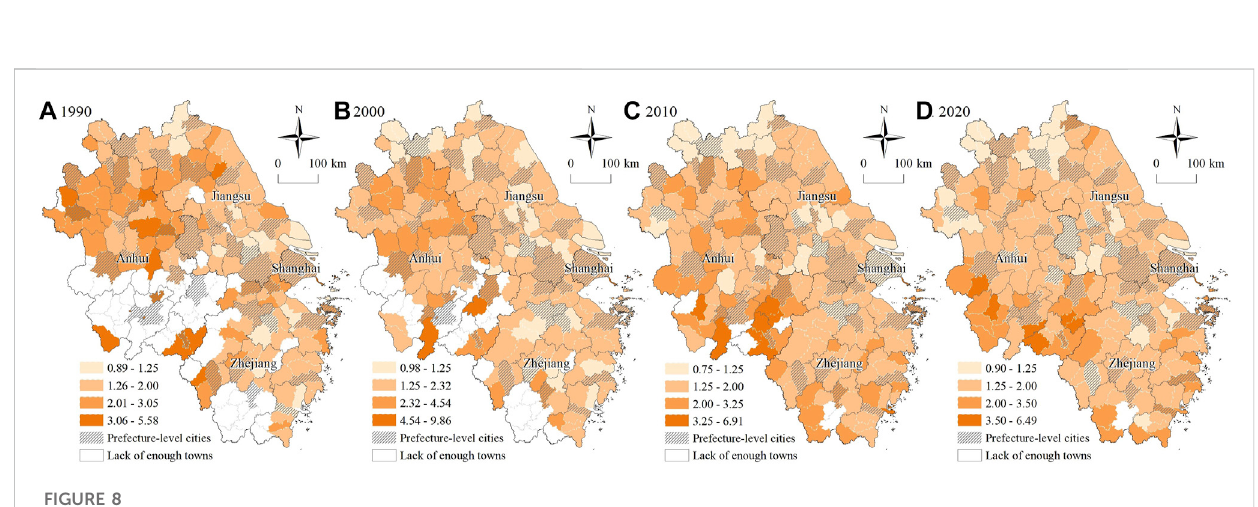
FIGURE 8 Spatio-Temporal distribution of the Pareto